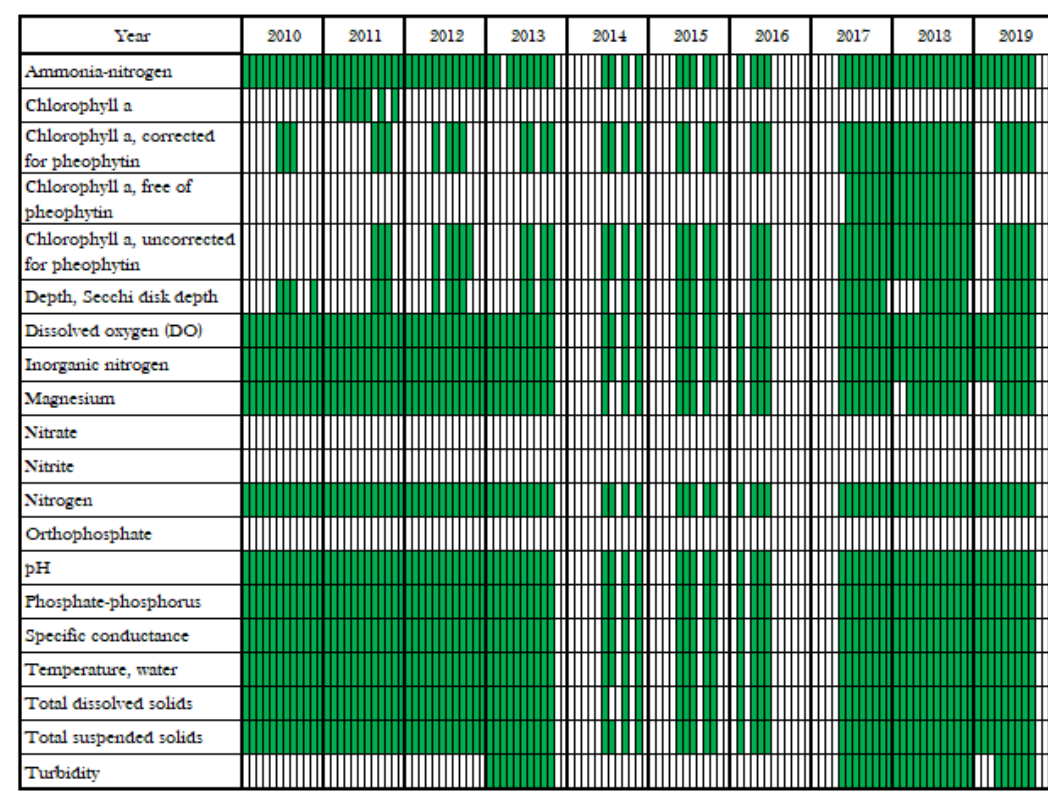
Figure 6. Available data for the selected parameters for at least one in-lake station in Utah Lake for the years 2010–2019.